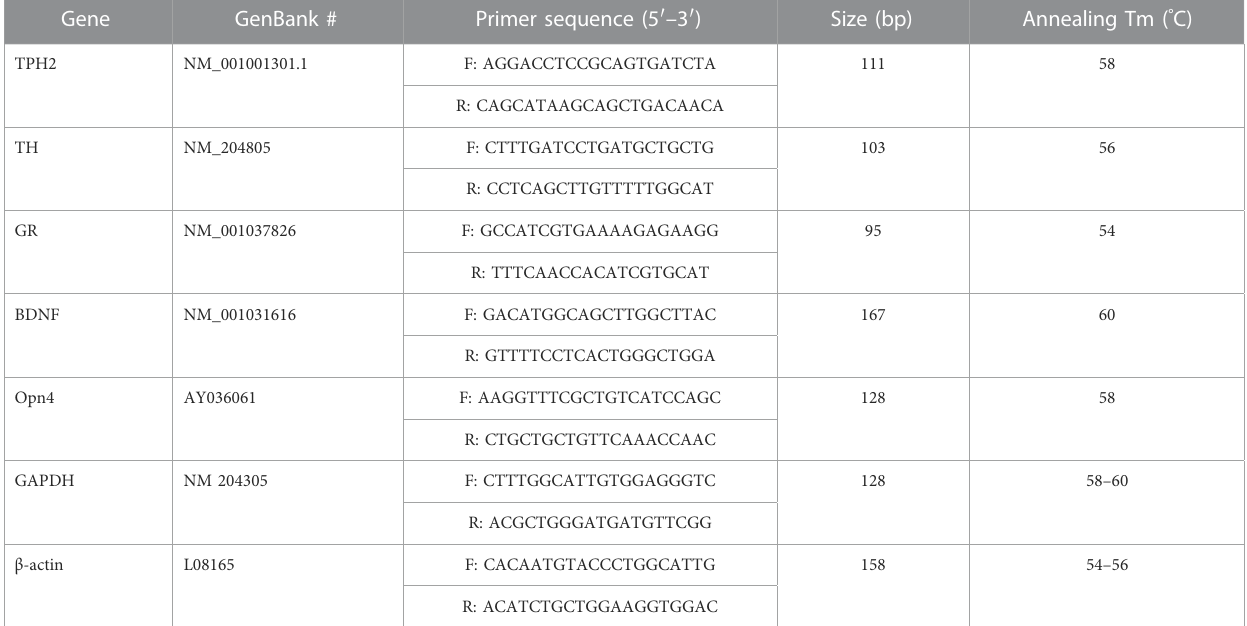
TABLE 1 Primers used for RT-qPCR. Gene GenBank # Primer sequence (5 ′ – 3 ′